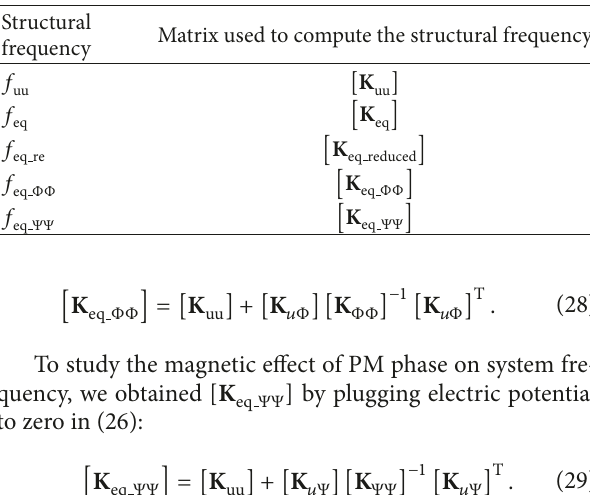
Table 2: List of f used in the